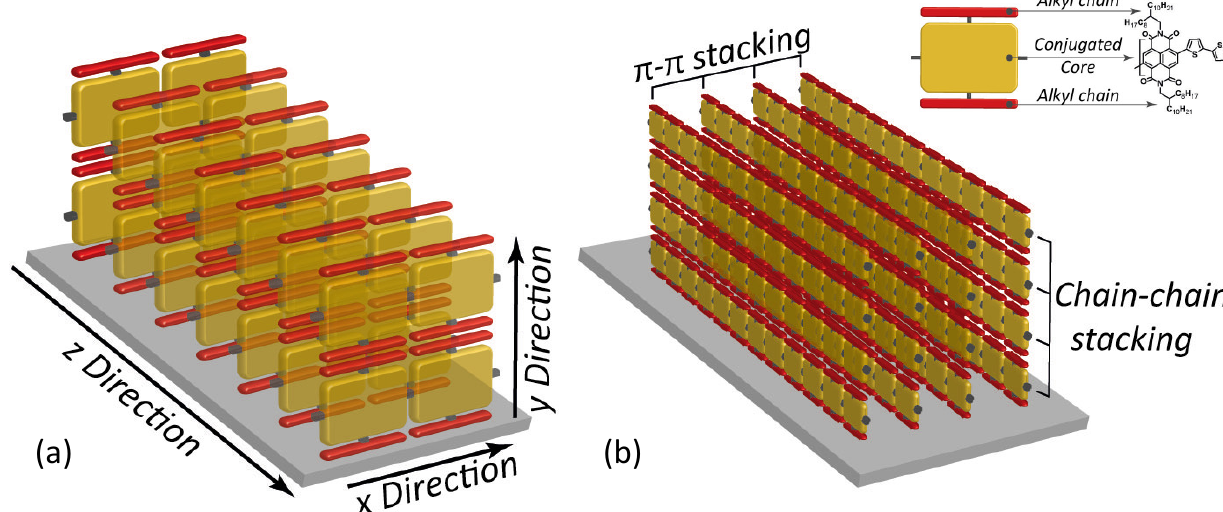
Figure 1. ( a ) Schematic depiction of charge transport in a edge-on packed polymer assembly. Yellow bricks indicate monomers along the polymer backbone. X, Y, Z denote the charge transport directions along the polymer chain, across the alkyl moieties of parallel chains and between face-to-face piled chains, respectively; ( b ) Schematic depiction of the π -stacking and chain-to-chain packing of polymers. In the inset, the reading-key shows the example of P(NDI2OD-T2) that is discussed